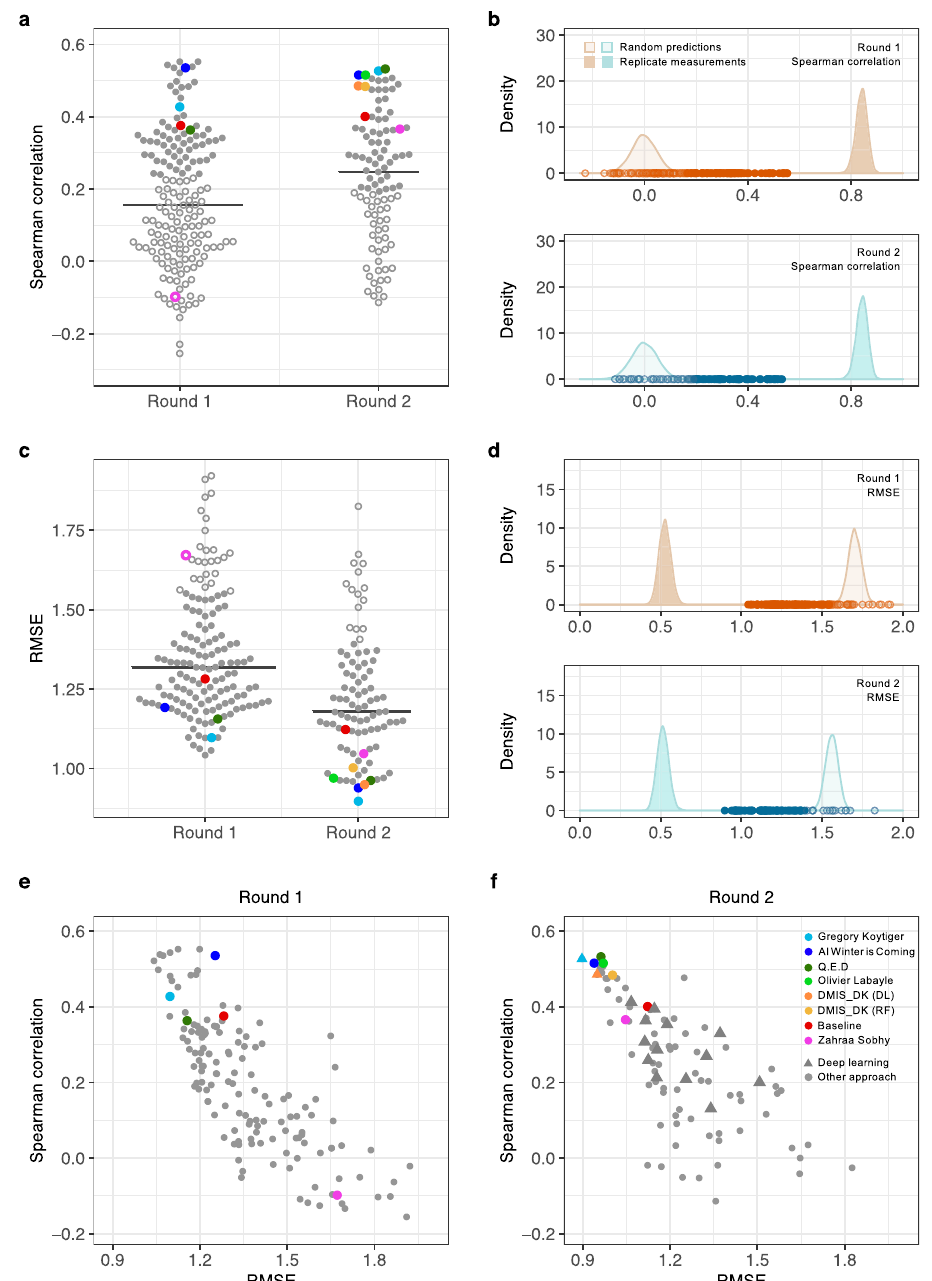
Fig. 3 Overall performance of the Challenge submissions. a , c Performance of the submissions in terms of the two winning metrics in Round 1 ( n = 169 submissions) and Round 2 ( n = 99 submissions). The horizontal lines indicate median correlation and the colors mark the baseline model and the top-performing participants in Round 2 (see the color legend of f ). The empty circles mark the submissions that did not differ from random predictions (the open pink circle indicates the Round 1 submission of Zahraa Sobhy as an example). The baseline model 17 remained the same in both of the rounds. b , d Distributions of the random predictions (based on 10,000 permuted pK d values) and replicate distributions (based on 10,000 subsamples with replacement of overlapping pK d pairs between two large-scale target activity pro fi ling studies 5,6 ) in Round 1 (top panel) and Round 2 (bottom). The points correspond to the individual submissions. e , f Relationship of the two winning metrics across the submissions in Round 1 and Round 2. The triangle shape indicates submissions based on deep learning (DL) in Round 2 ( f ). For instance, team DMIS_DK submitted predictions based both on random forest (RF) and DL algorithms in Round 2, where the latter showed slightly better accuracy. A total of 33 submissions with Root Mean Square Error (RMSE) >2 are omitted in the RMSE results ( c , e , f ). Source data are provided as a Source Data fi le 54